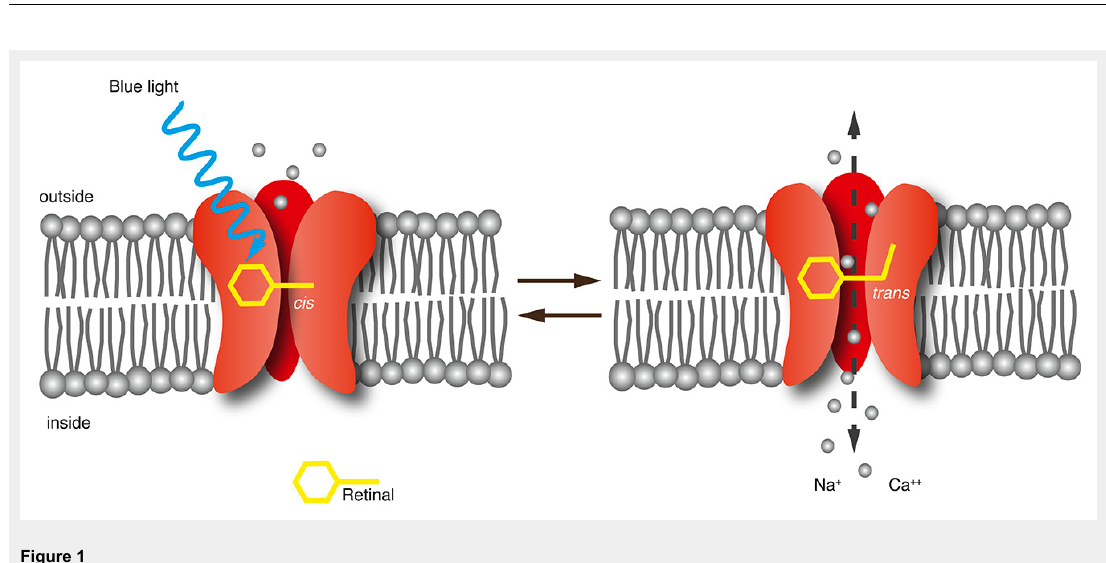
Principle of optogenetics . Channelrhodopsin is an ion channel that binds retinal. With blue light exposure the retinal confirmation changes from cis to trans , which gates the ion conductance leading to depolarisation. When expressed in neurons this technique allows the activity to be